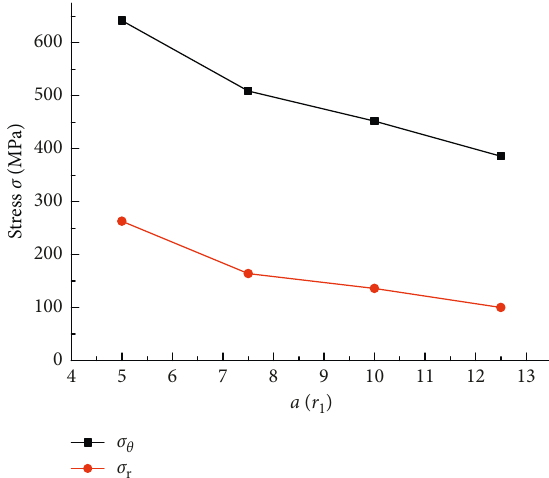
Figure 8: The peak stress on adjacent empty holes wall varies with the hole